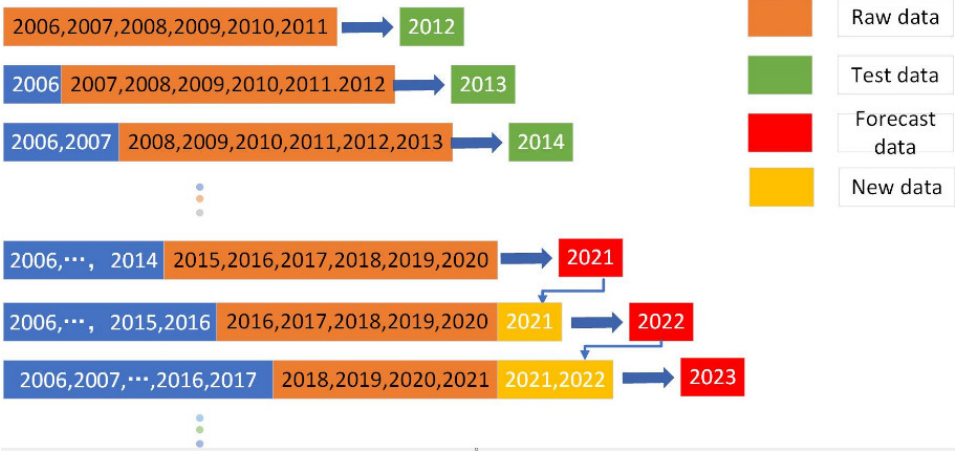
Figure 4. Modeling and prediction process of GRPM (1,1).